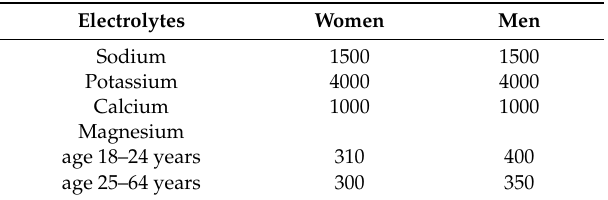
Table 1. Reference Values for electrolyte intake in mg / d according to the Nutrition Societies of Germany, Austria and Switzerland (D-A-CH) [2].